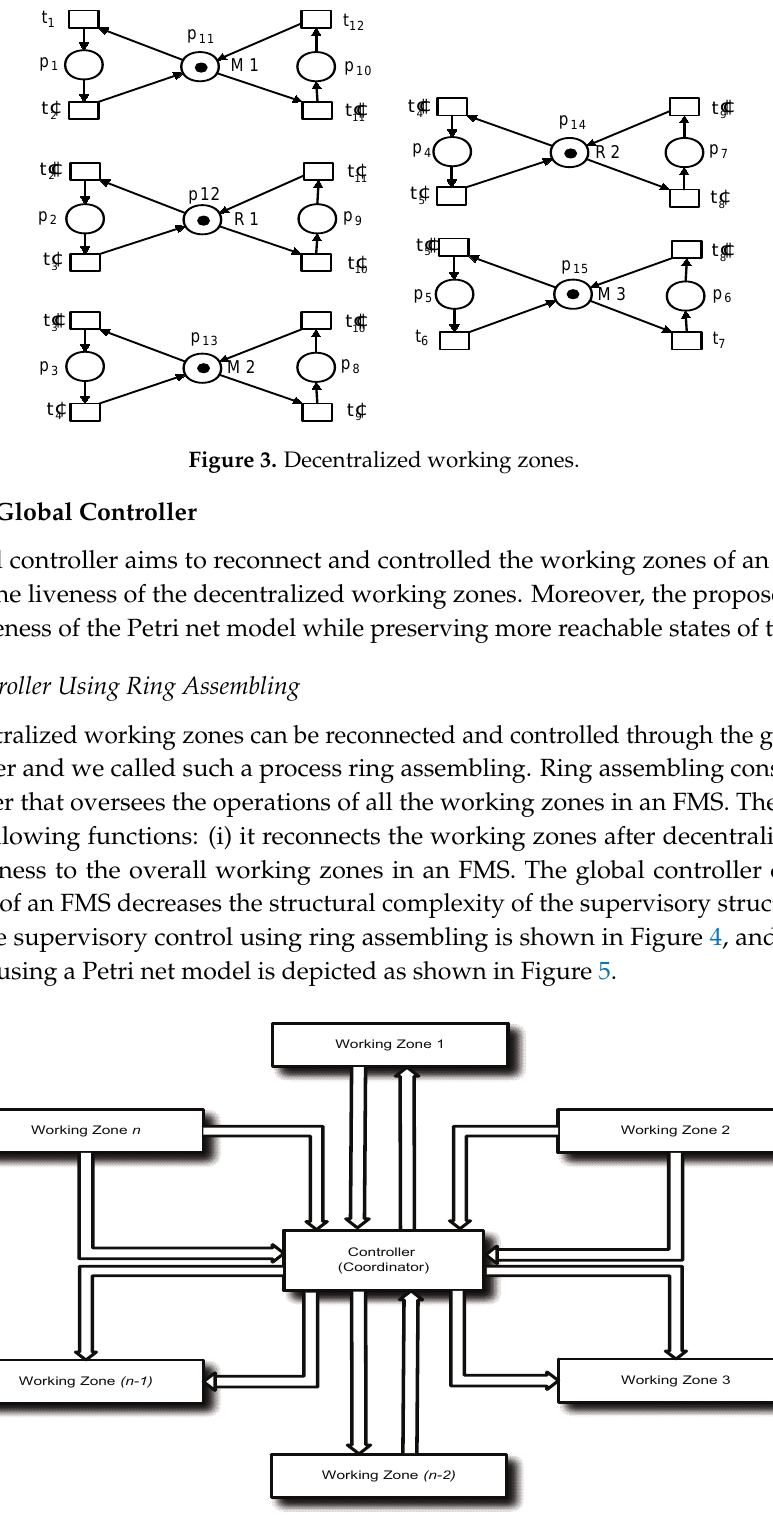
Figure 4. Block diagram of global controllers using ring